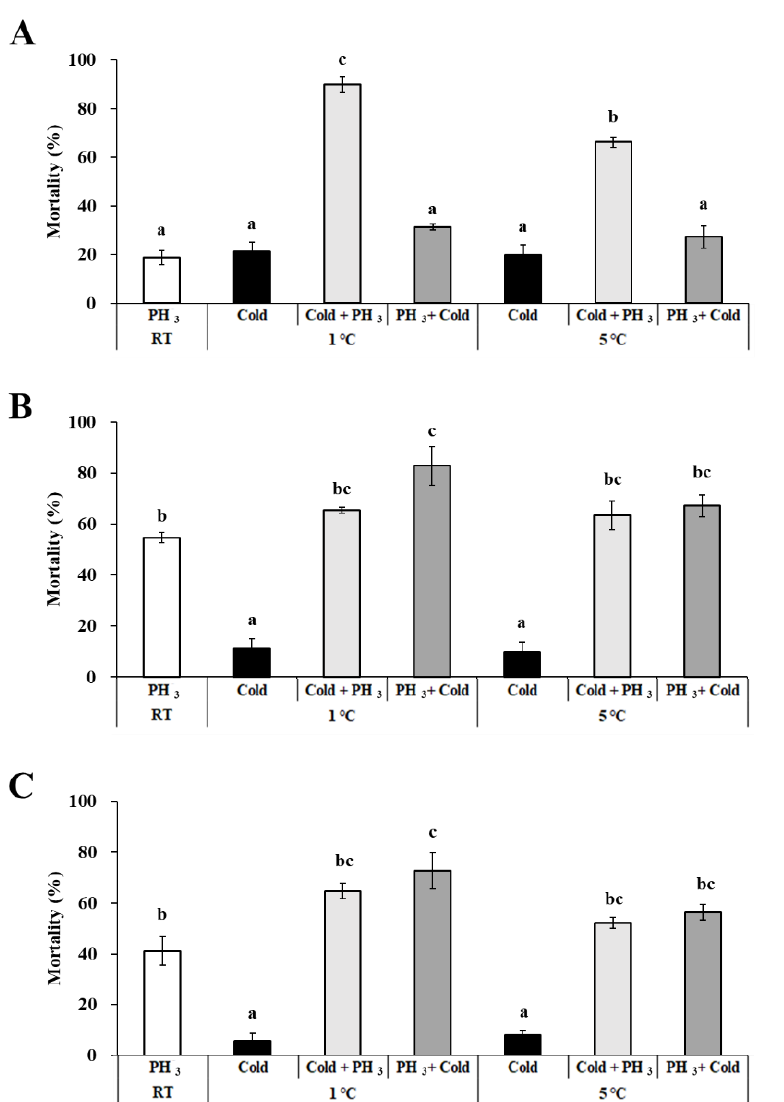
Figure 2. Effects of single treatments and combined treatments on the control of each D. suzukii developmental stage in a 12 L desiccator. ( A ): eggs; ( B ): larvae; ( C ): pupae. Different letter above the bars indicates significant difference.